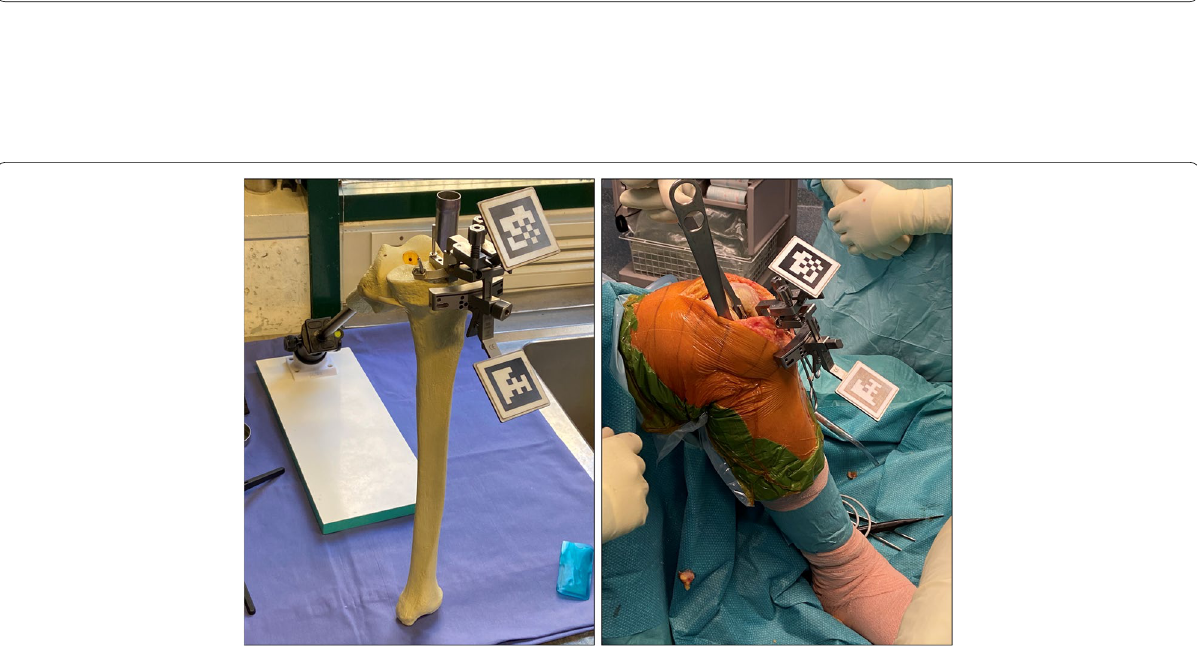
Fig. 4 After registration phase, the surgeon could insert the tibial resection guide and fix the resection block when the desired angles of varus/ valgus and tibial slope have been